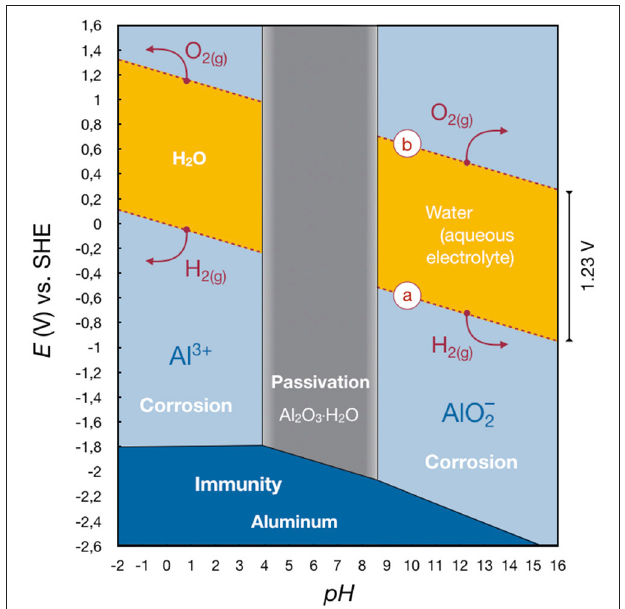
FIGURE 3 | Pourbaix diagram of aluminum in water at 25 ◦ C showing its corrosion behavior. It depicts the basic oxidation/reduction reactions for aluminum in aqueous systems. Outside the yellow region, water breaks down, not the metal. It can be seen that a secondary aluminum-ion battery with an aluminum metal as negative electrode based on an aqueous system will not be possible since the aluminum cannot be plated both at low and high pH . It cannot be solved in a medium pH , as well. Therefore, just primary battery systems can be realized (cf. section Aqueous or Primary Aluminum Battery). Redrawn from Deltombe and Pourbaix (1958), Vargel (2004), and Ashby and Jones